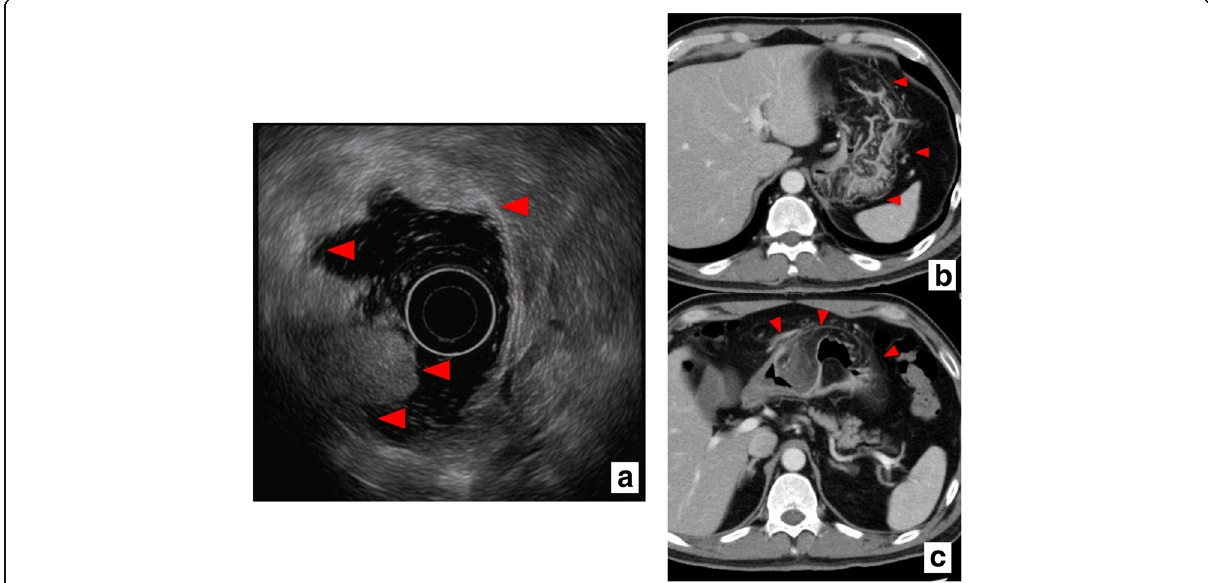
Fig. 2 Findings on EUS and CT. EUS ( a ) and CT ( b , c ) findings are shown. EUS shows a high-echoic lesion in the antral wall submucosa (red triangle), extending to the stomach. CT shows a huge fat-containing mass lesion around the gastric wall, excluding the lesser curvature (red triangle). Abbreviations: CT computed tomography, EUS endoscopic